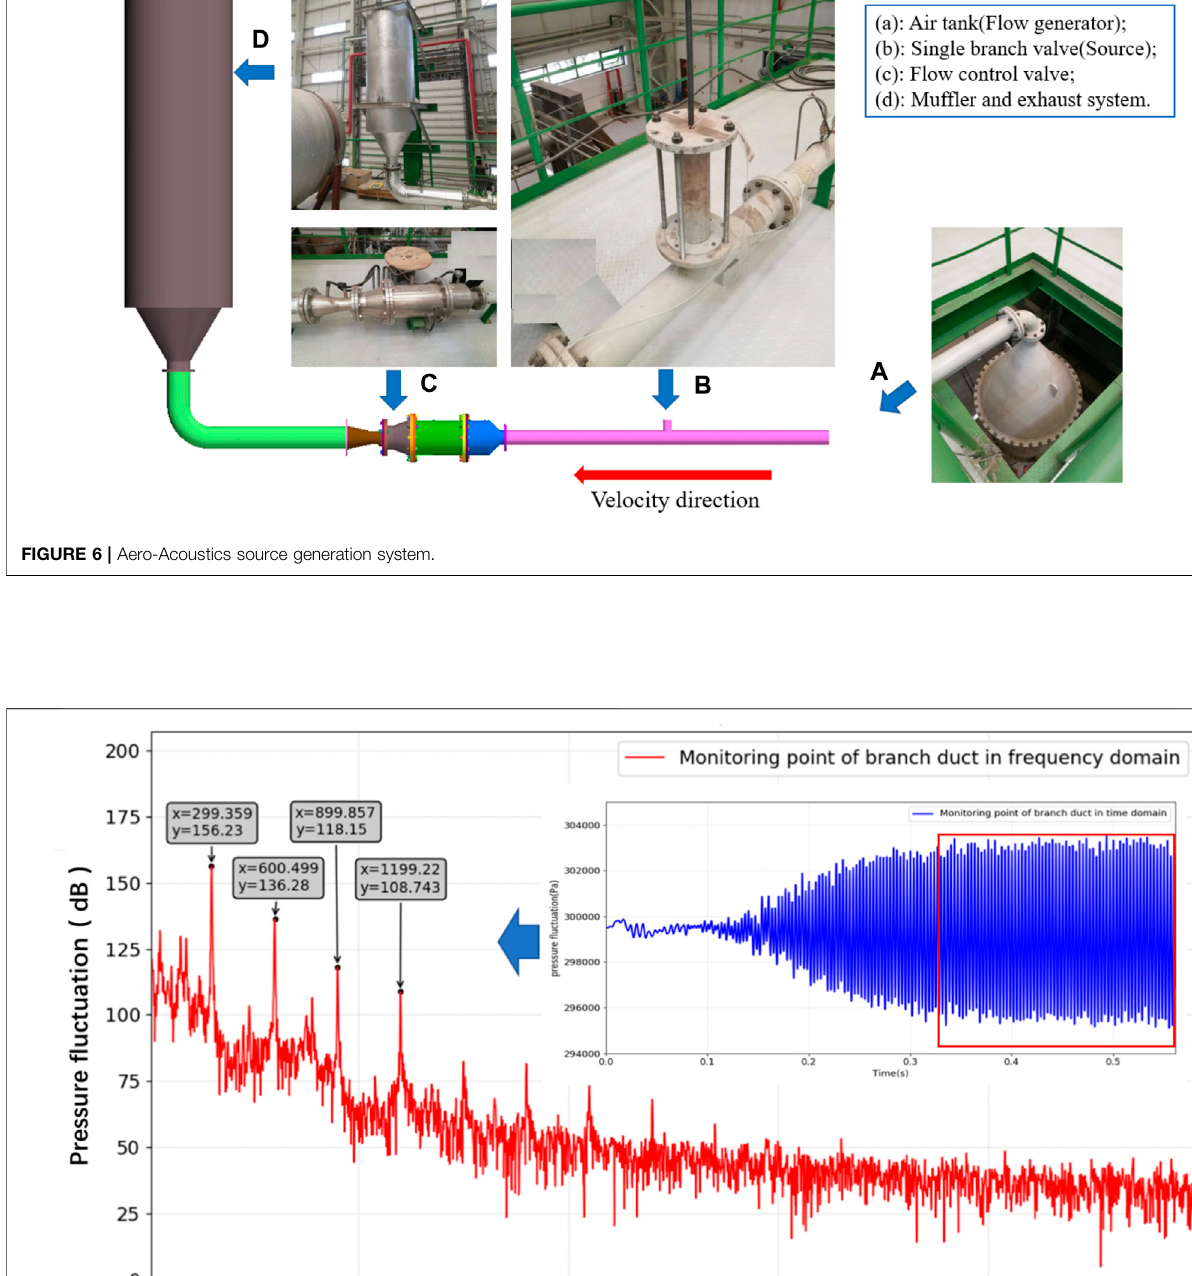
Frontiers in Materials |